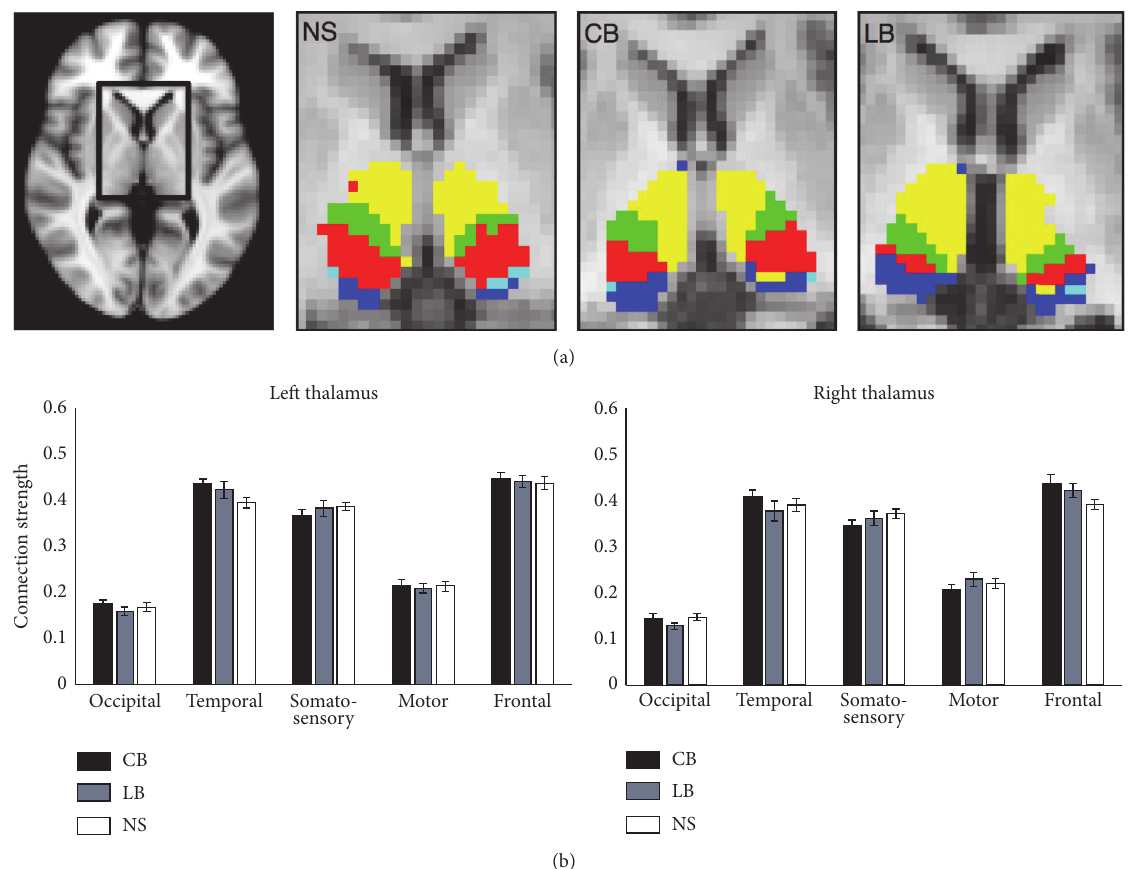
Figure 2: (a) Find-the-biggest segmentation within thalamus in a CB, LB, and NS participant. (b) Bar plot of the thalamocortical connectivity strength for the left and right thalamus for all CB, LB, and NS subjects. The 𝑦 -axis represents the marker of connection strength between the thalamus and each cortical target mask, as measured by the seed to target connectivity count normalised with the total number of streamlines. Error bars indicate the standard error of the